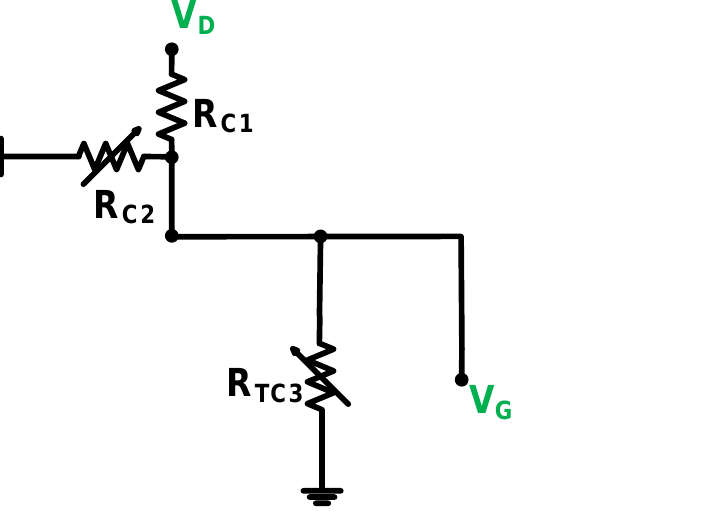
Figure 5. Equivalent circuit models of voltage divider with high-voltage transistor and switching diodes for DC analysis.